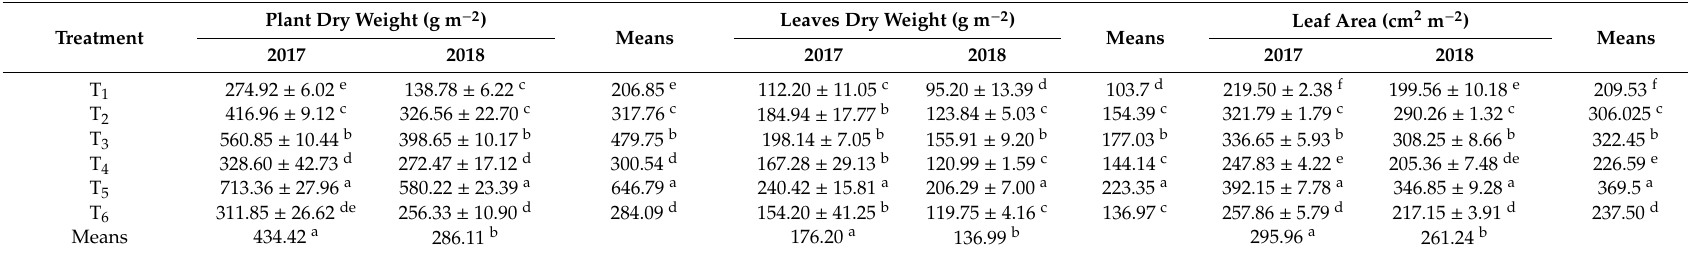
Table 4. E ff ect of organic, inorganic, and biofertilizers on plant growth characteristics (plant dry yield, leaves dry yield, and leaf area) of Jew’s mallow ( Corchorus olitorius L.)